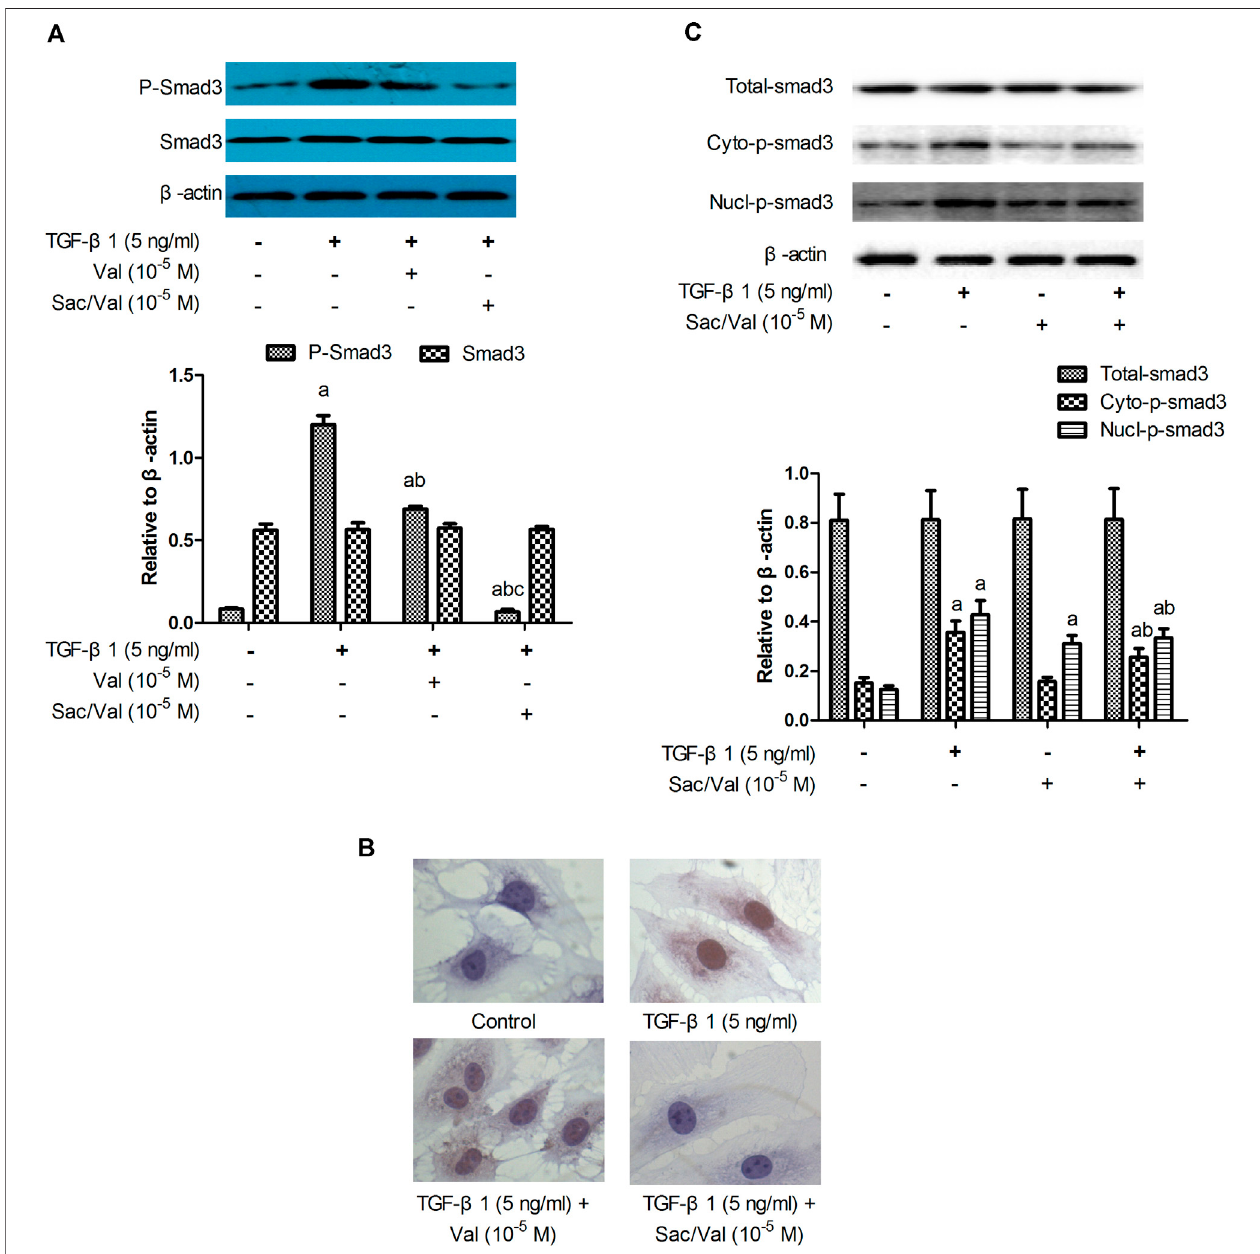
FIGURE 6 | Effects of sacubitril/valsartan on TGF- β 1 -induced Smad3 phosphorlation and nucleus translocatoin in myocardial fi broblasts. MFs were pretreated withsacubitril/valsartan(10 5 M)orvalsartan(10 5 M)for45 minbeforeaddingTGF- β 1(5 ng/ml)for60 min (A) Smad3phosphorlationdeterminedbyimmunoblotting. (B) Smad3 subcellular localization detected by immunocytochemistry (objective 40 × ). (C) Smad3 subcellular localization demonstrated by immunoblotting. TGF- β 1, transforming growth factor- β 1; Val, valsartan; Sac/Val, sacubitril/valsartan; Cyto-p-Smad3, phosphorylated Smad3 in the cytoplasm; Nucl-p-Smad3, phosphorylated Smad3 in the nucleus; Results are mean ± SD (n (cid:1) 3); a P < 0.05 vs. TGF- β 1 (0 ng/ml); b P < 0.05 vs. TGF- β 1 (5 ng/ml); c P < 0.05 vs. Val.